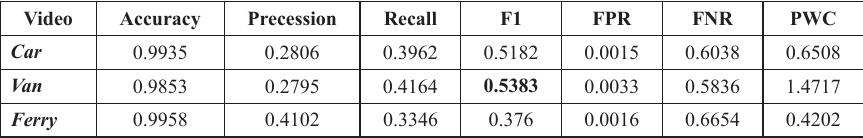
Table 3. Performance metrics results of applying ViBe model